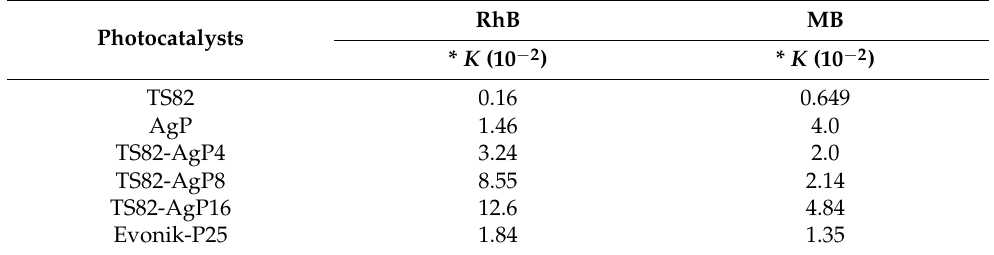
Table 2. Photocatalytic reaction rate constants of RhB and MB dye degradation under solar light. Photocatalysts